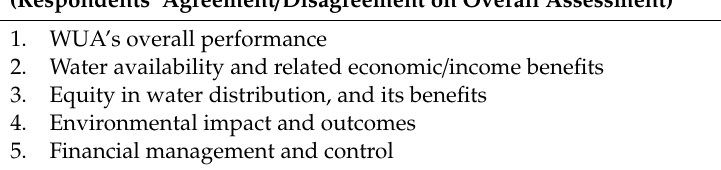
Table A4. Overall assessment of PIM institution’s